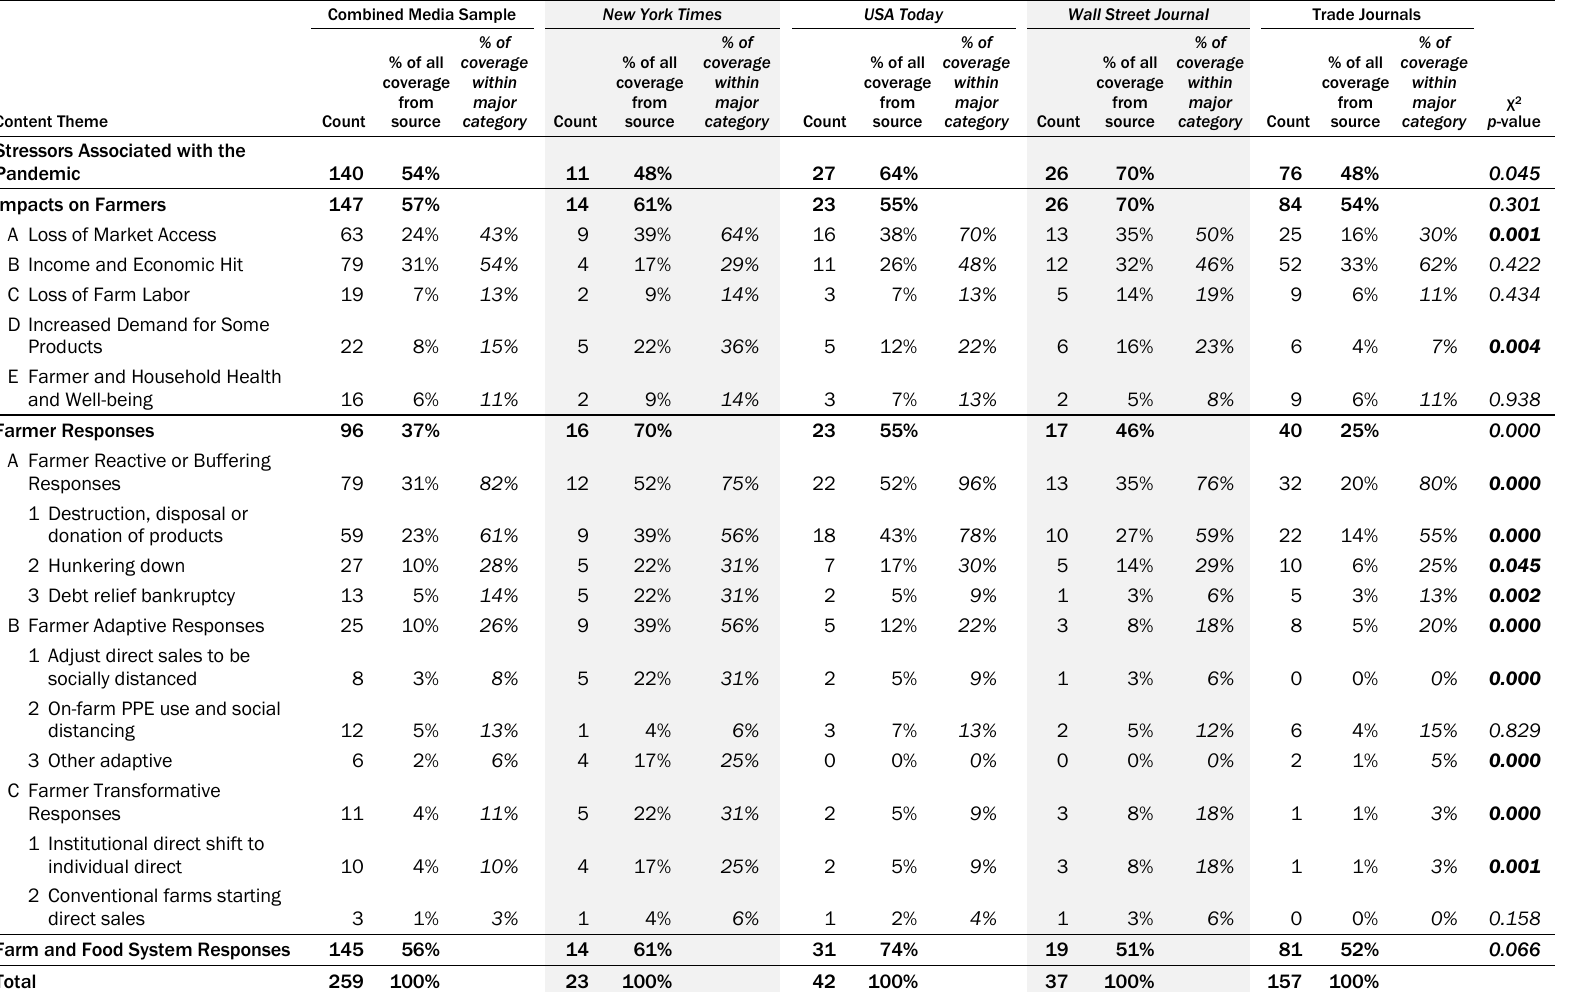
Table 2. Number and Percent of Articles Coded on Each Theme, by